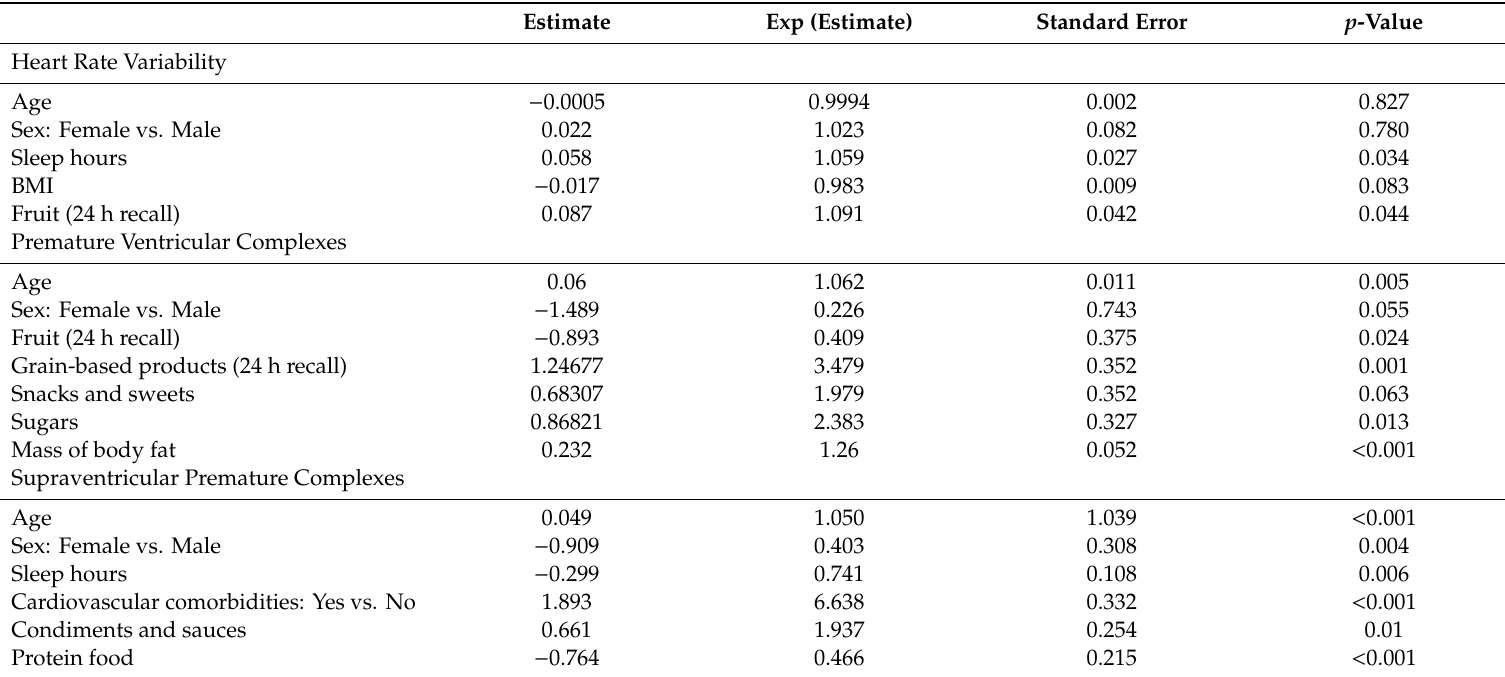
Table 4. Multivariable analysis for premature ventricular complexes, supraventricular premature complexes, and heart rate variability. Estimates are changes in PVCs for a unit increase of each of the predictors, Exp (Estimate) represents E[(Y + 1); X] / E [Y; X] indicating the relative variation in the expected number of arrhythmic events consequently to a unit increase of each considered X